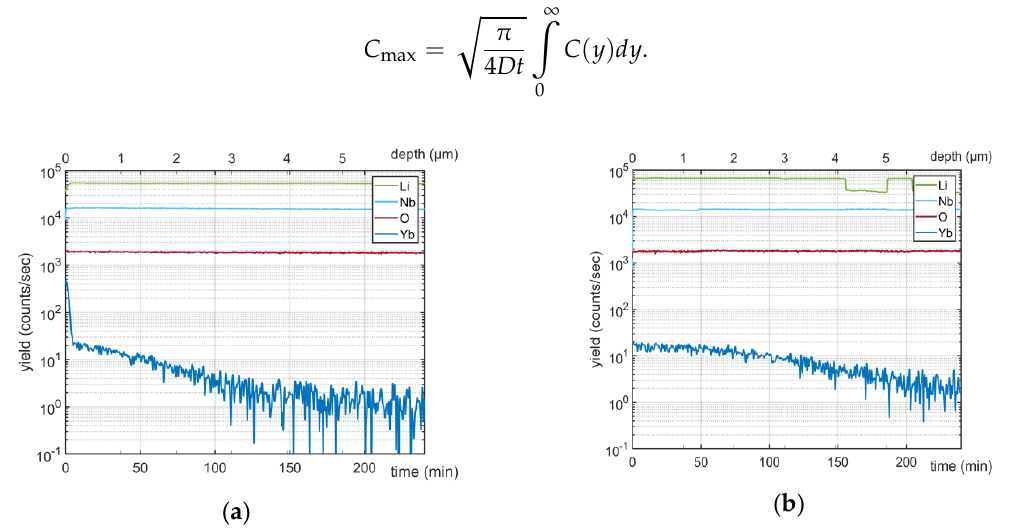
Figure 1. Secondary neutral mass spectrometry (SNMS) spectra of x-cut Yb:LiNbO 3 . The two samples were coated with 20 nm Yb, and the diffusion parameters are (a) T = 1060 °C, t = 30 h and (b) T = 1130 °C, t = 30 h, respectively.